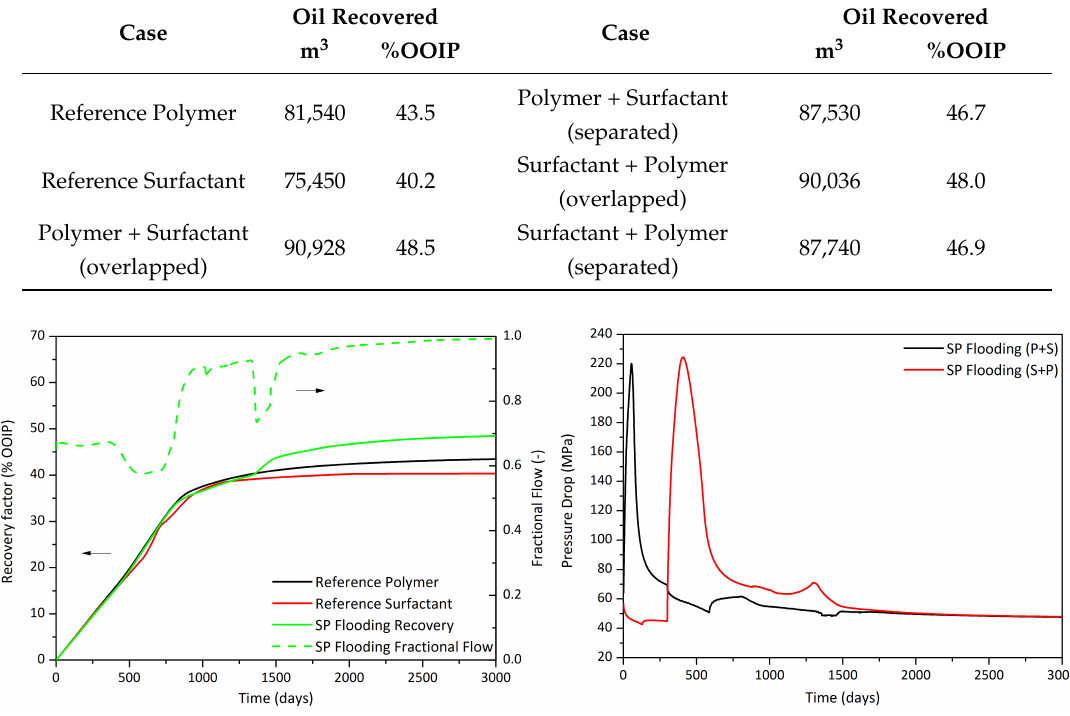
Figure 5. Oil recovery, fractional flow ( left ) and pressure drop ( right ) for the reference and SP schemes cases considering